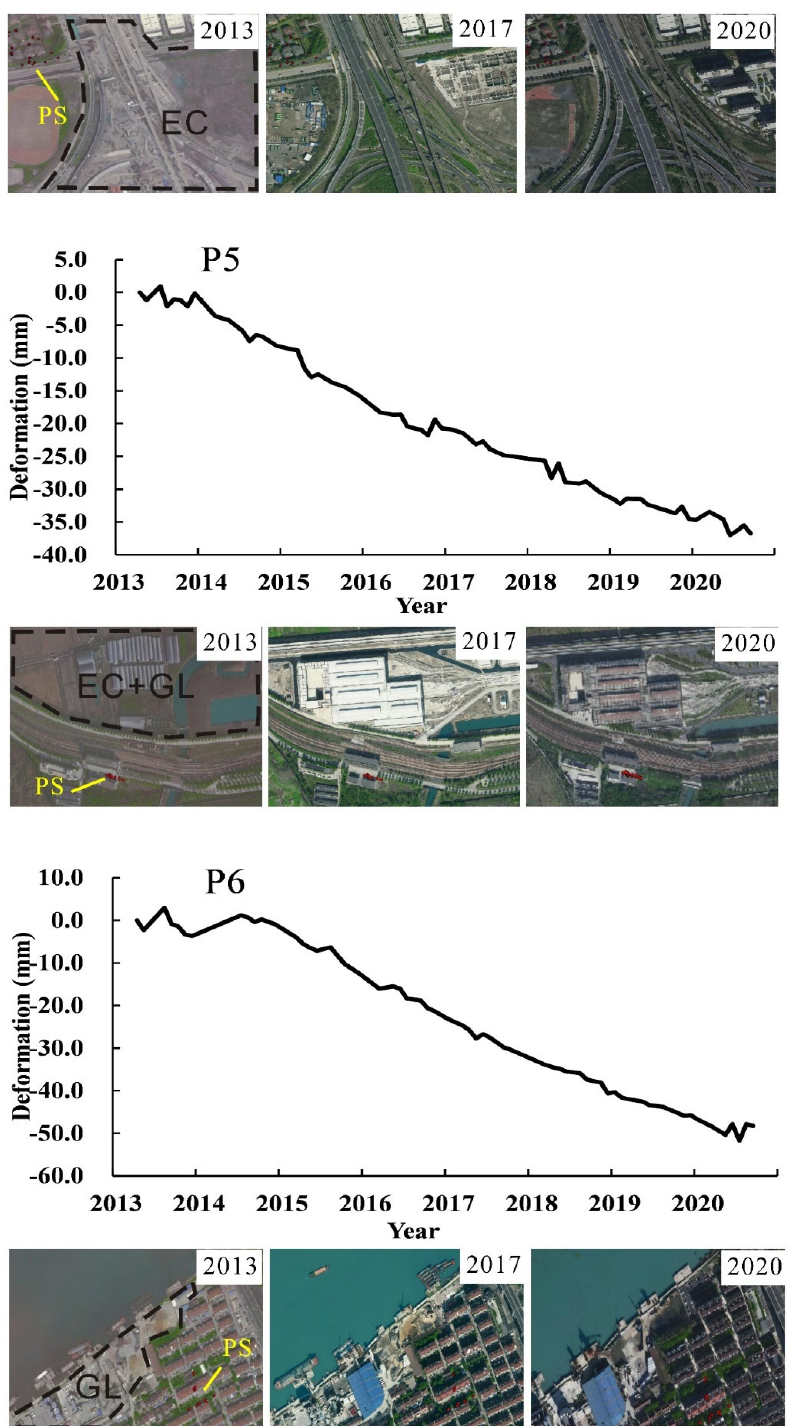
Figure 10. Curve of time series ground deformation and aerial images of the surrounding land cover change (EC: engineering construction, GL: ground load). Plots (P1)–(P6) shows the ground deformation and the corresponding aerial images respectively in the six areas, labeled as P1, P2, P3, P4, P5, P6.